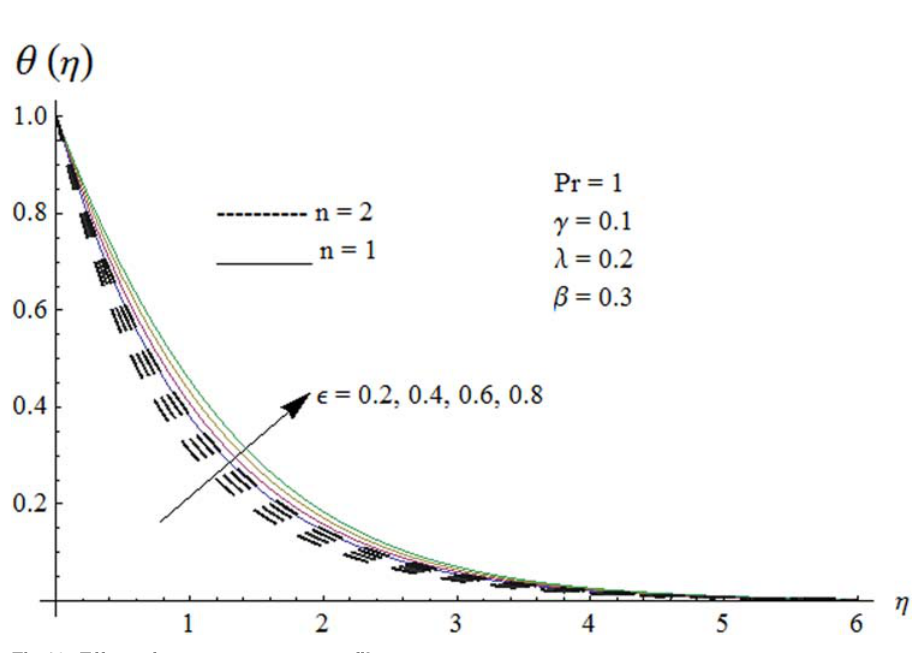
Fig 12. Effect of ε on temperature profile.